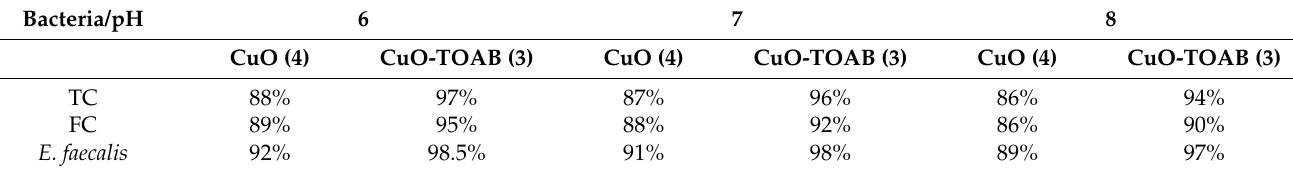
Table 4. The antibacterial effects of pH 6, 7 and 8 using CuO nanoparticles alone and modified with a surfactant (TOAB(3)) [114].